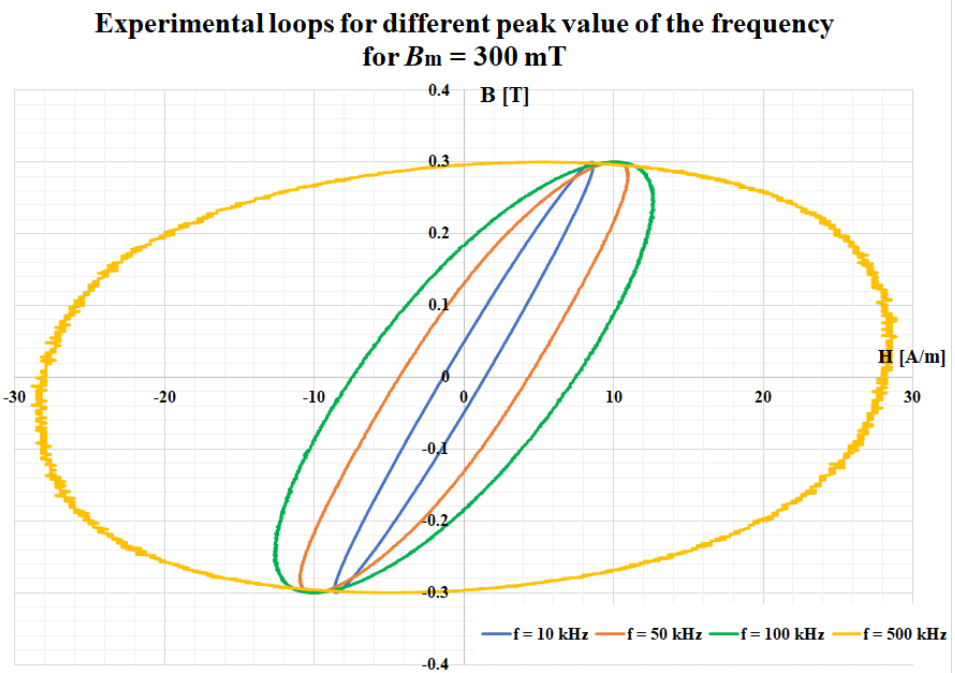
Figure 5. Comparison between experimental loops for different values of the frequency obtained at 300 mT.